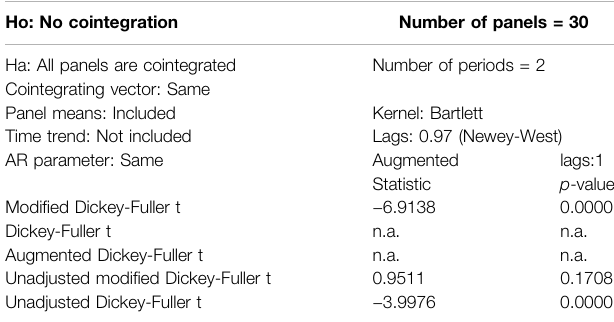
TABLE 4 | Kao test for